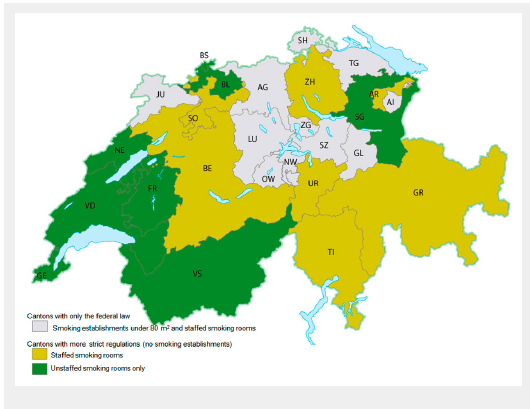
Map of the different cantonal legislations regarding exposure to second-hand tobacco smoke.